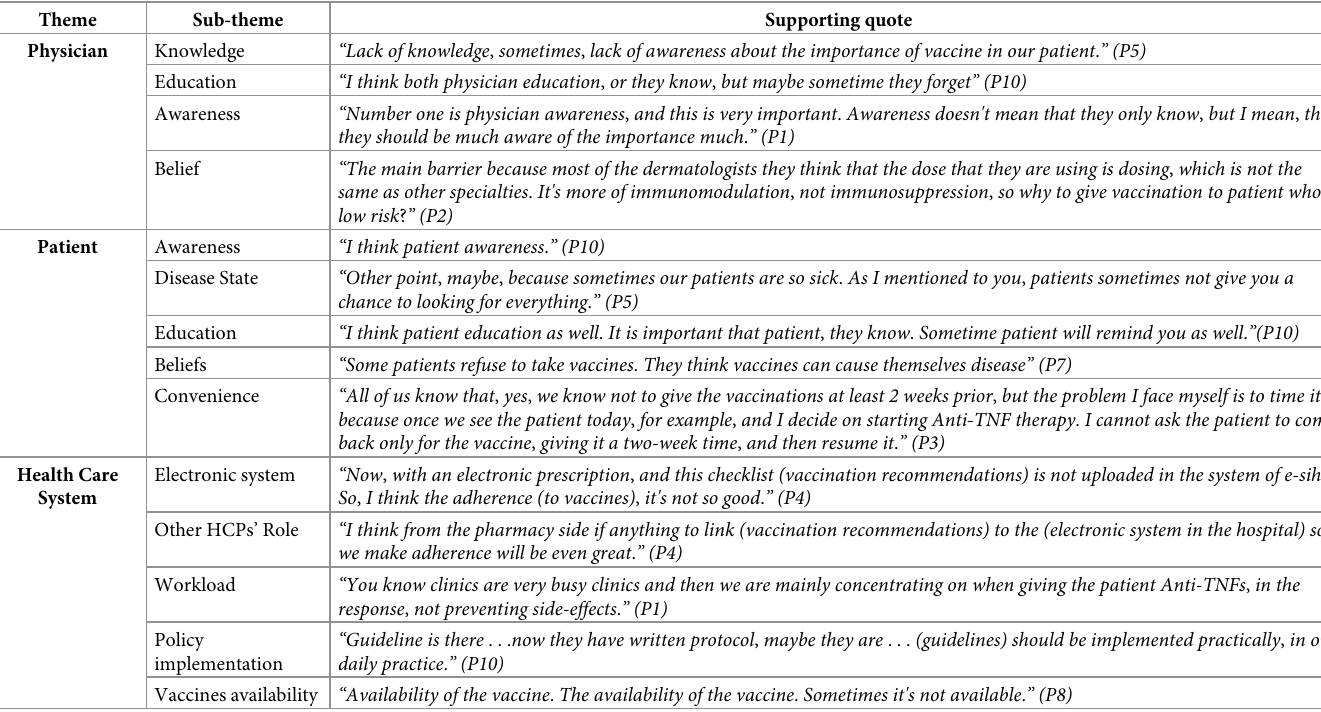
Table 5. Findings of the Thematic Analysis regarding factors that hinder vaccination in patients receiving Anti-TNF. Theme